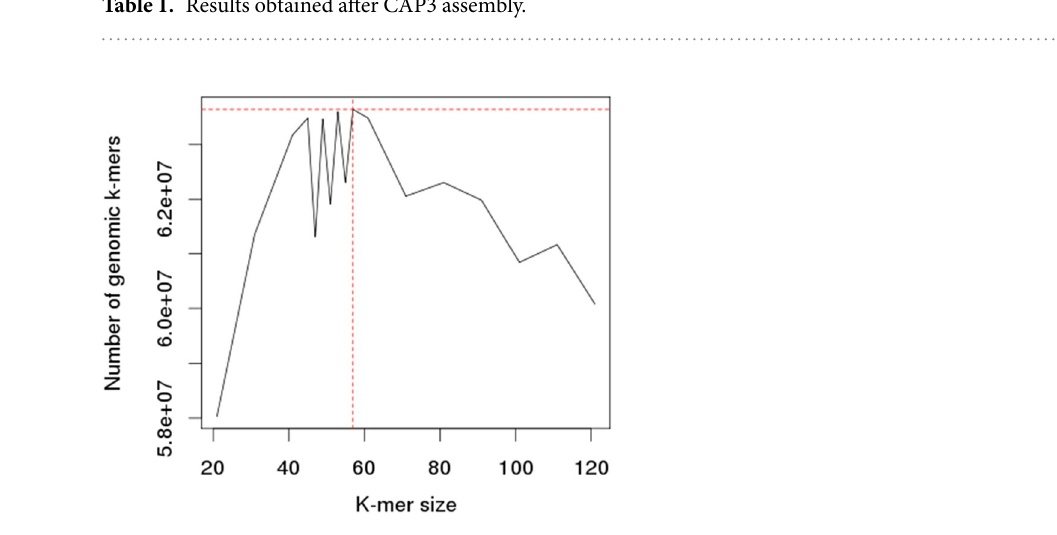
Figure 1. Estimation of genome size and k -mer value using kmergenie